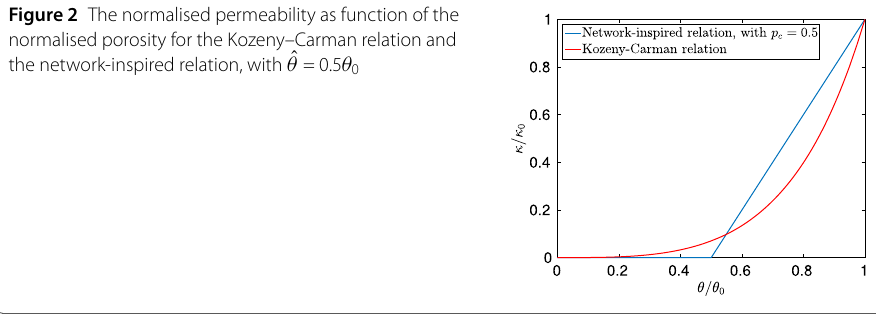
Figure 2 The normalised permeability as function of the normalised porosity for the Kozeny–Carman relation and the network-inspired relation, with ˆ θ = 0.5 θ